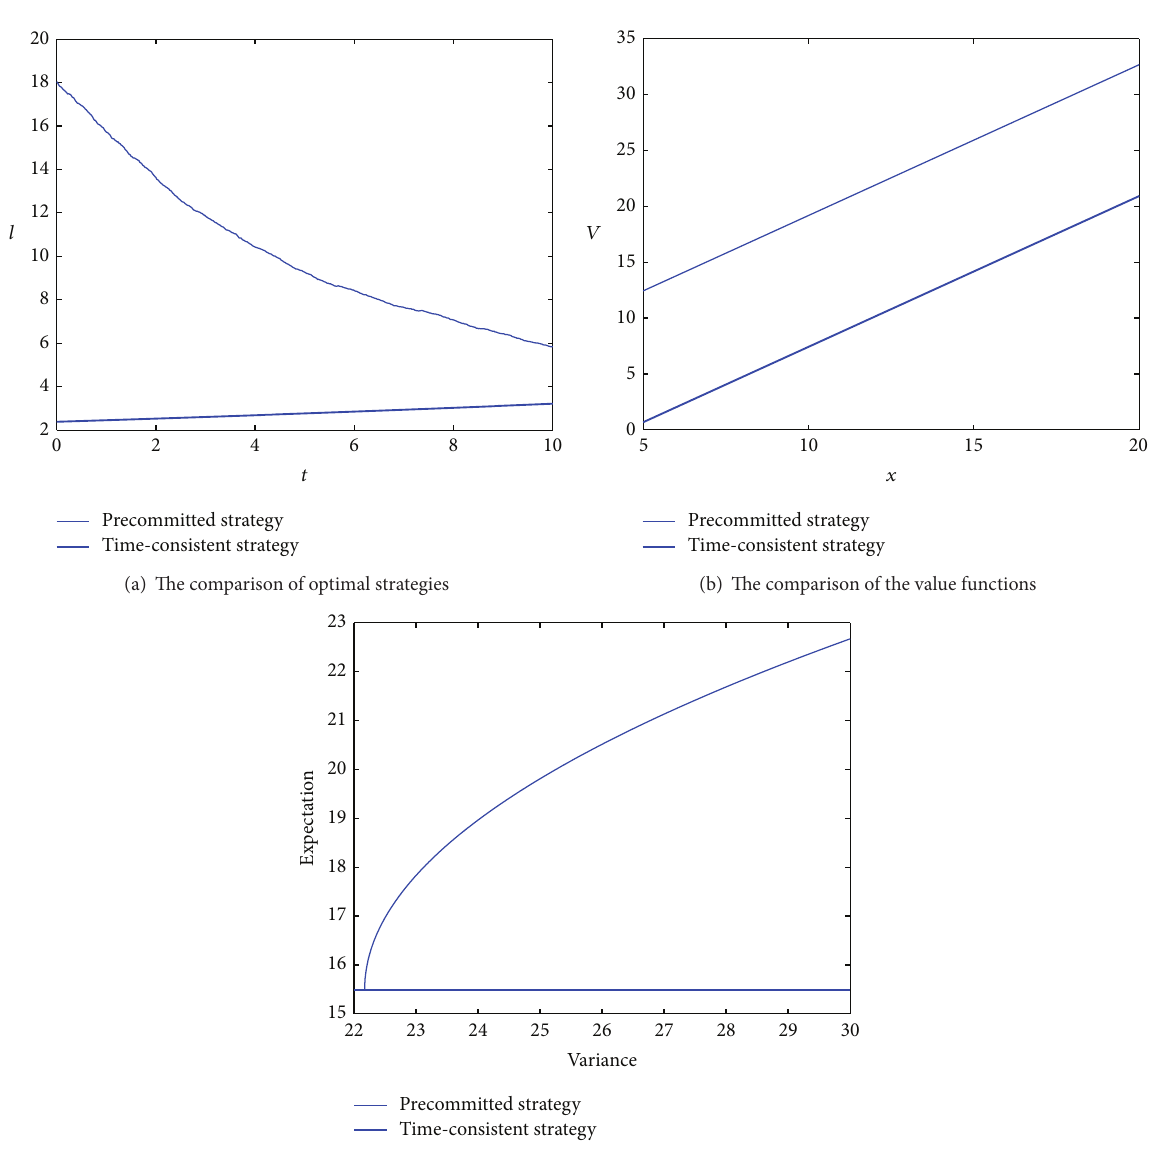
Figure 6: The comparisons between the precommitted strategy and the time-consistent